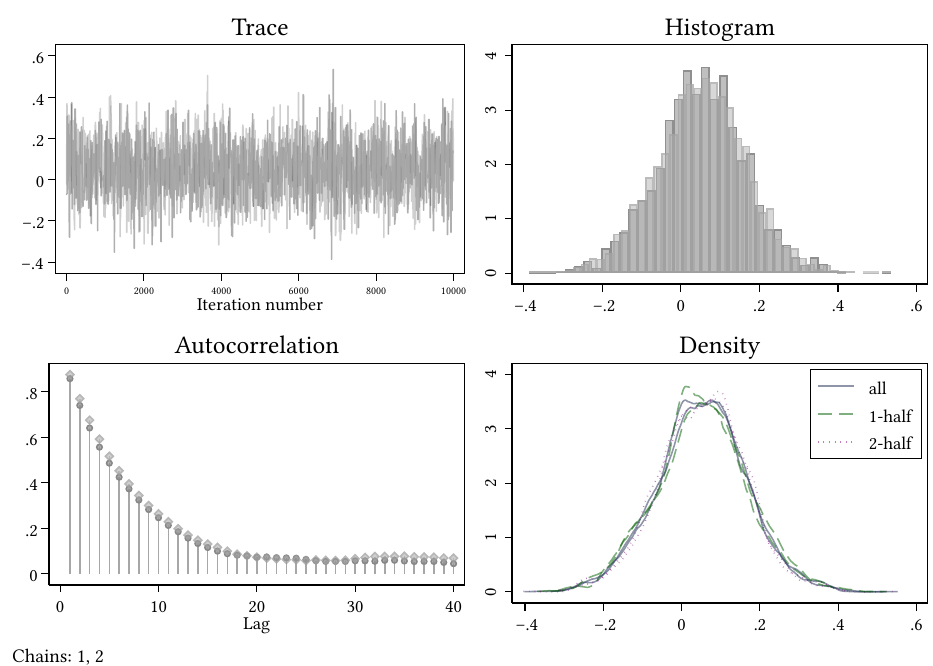
Figure A5. How awareness of the price effect influences response to extreme ask. The High Info group.